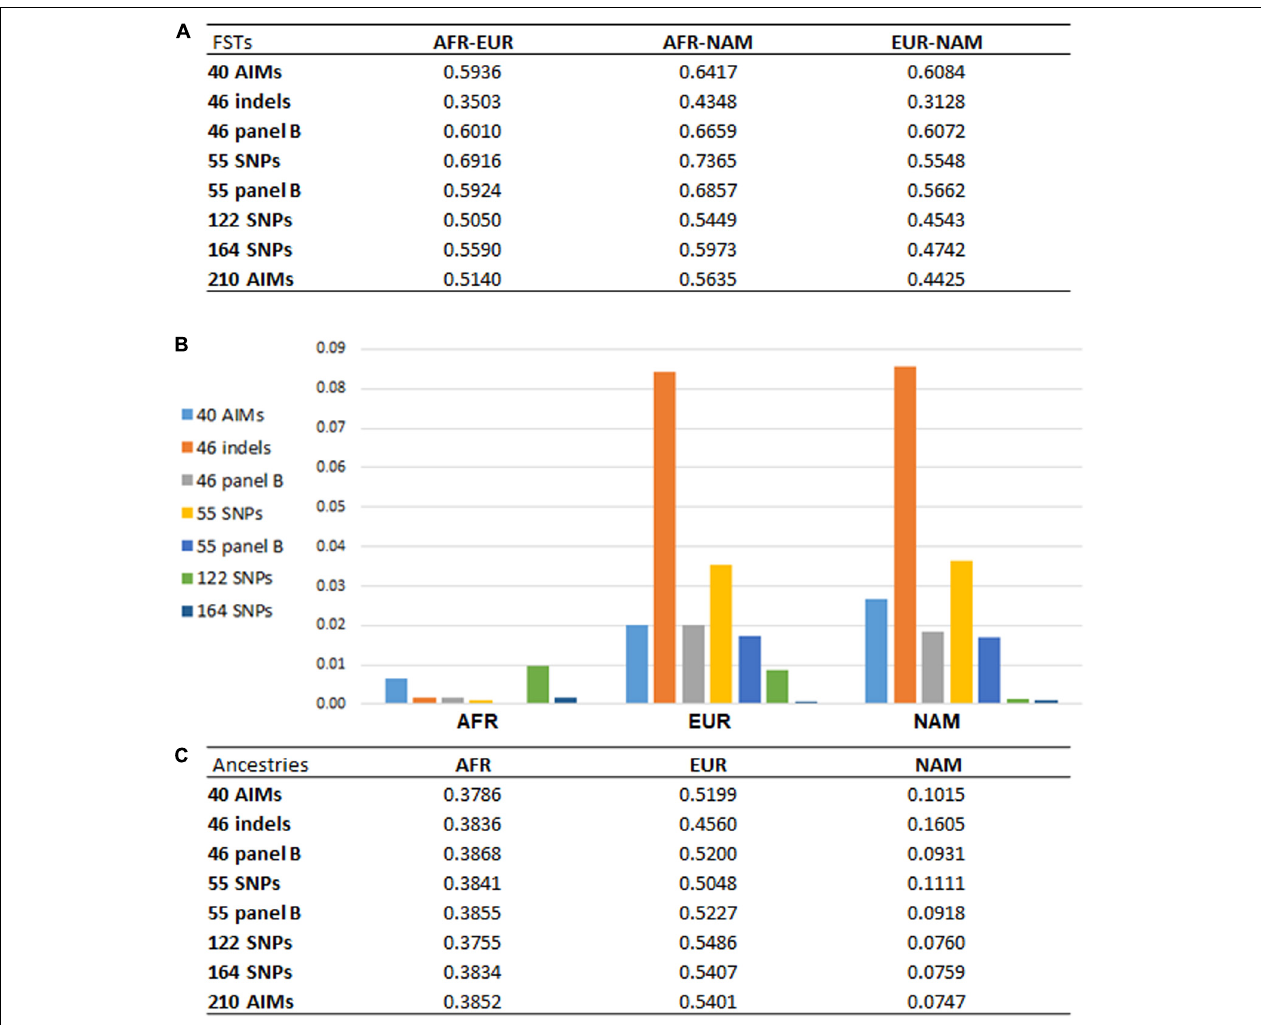
FIGURE 7 | (A) pairwise FST values among reference populations (AFR, N = 100; EUR, N = 100; NAM, N = 47) based on the different AIM panels; (B) absolute values of the differences between the average ancestries reported for each panel compared to the 210 AIMs; (C) average ancestry values per component and per panel for unrelated